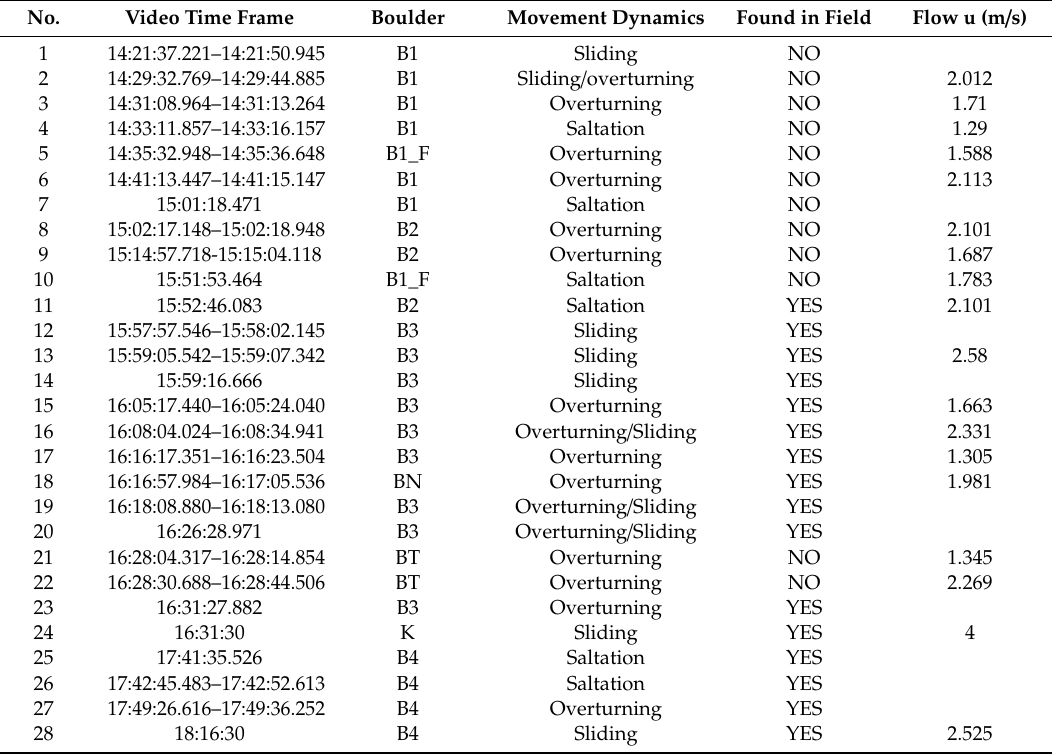
Table 2. Results of video analyses of boulder displacements detected in the Maddalena